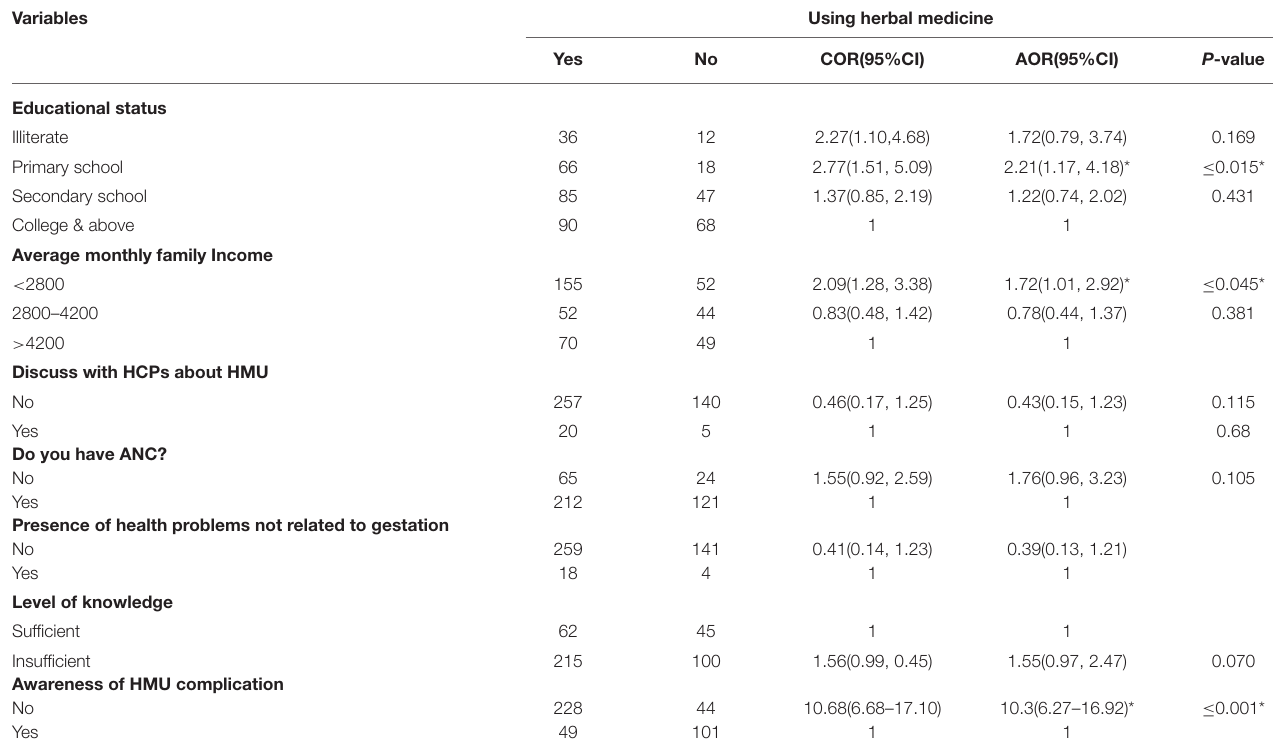
TABLE 3 | Bivariable and multivariable binary logistic regression analysis for factors associated with utilization of herbal medicine among pregnant mothers at public health institutions in Debre Berhan town, Ethiopia, 2021 ( n = 422).